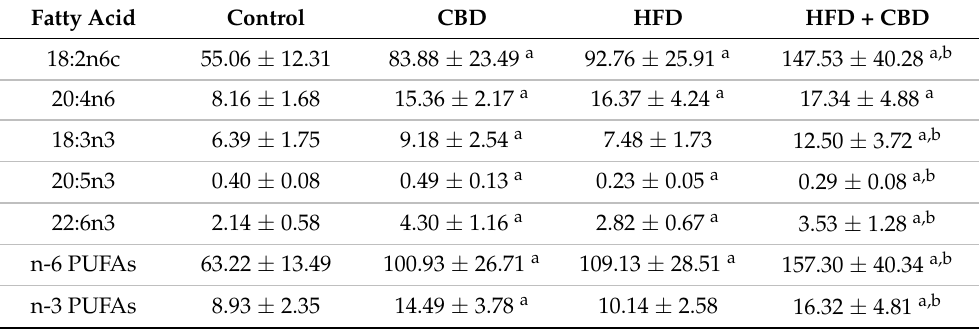
Table 9. Polyunsaturated fatty acids (PUFA) content in the plasma FFA fraction (nmol/mL of plasma) in the control (standard diet) and high-fat diet (HFD) groups after two-week cannabidiol (CBD) treatment.